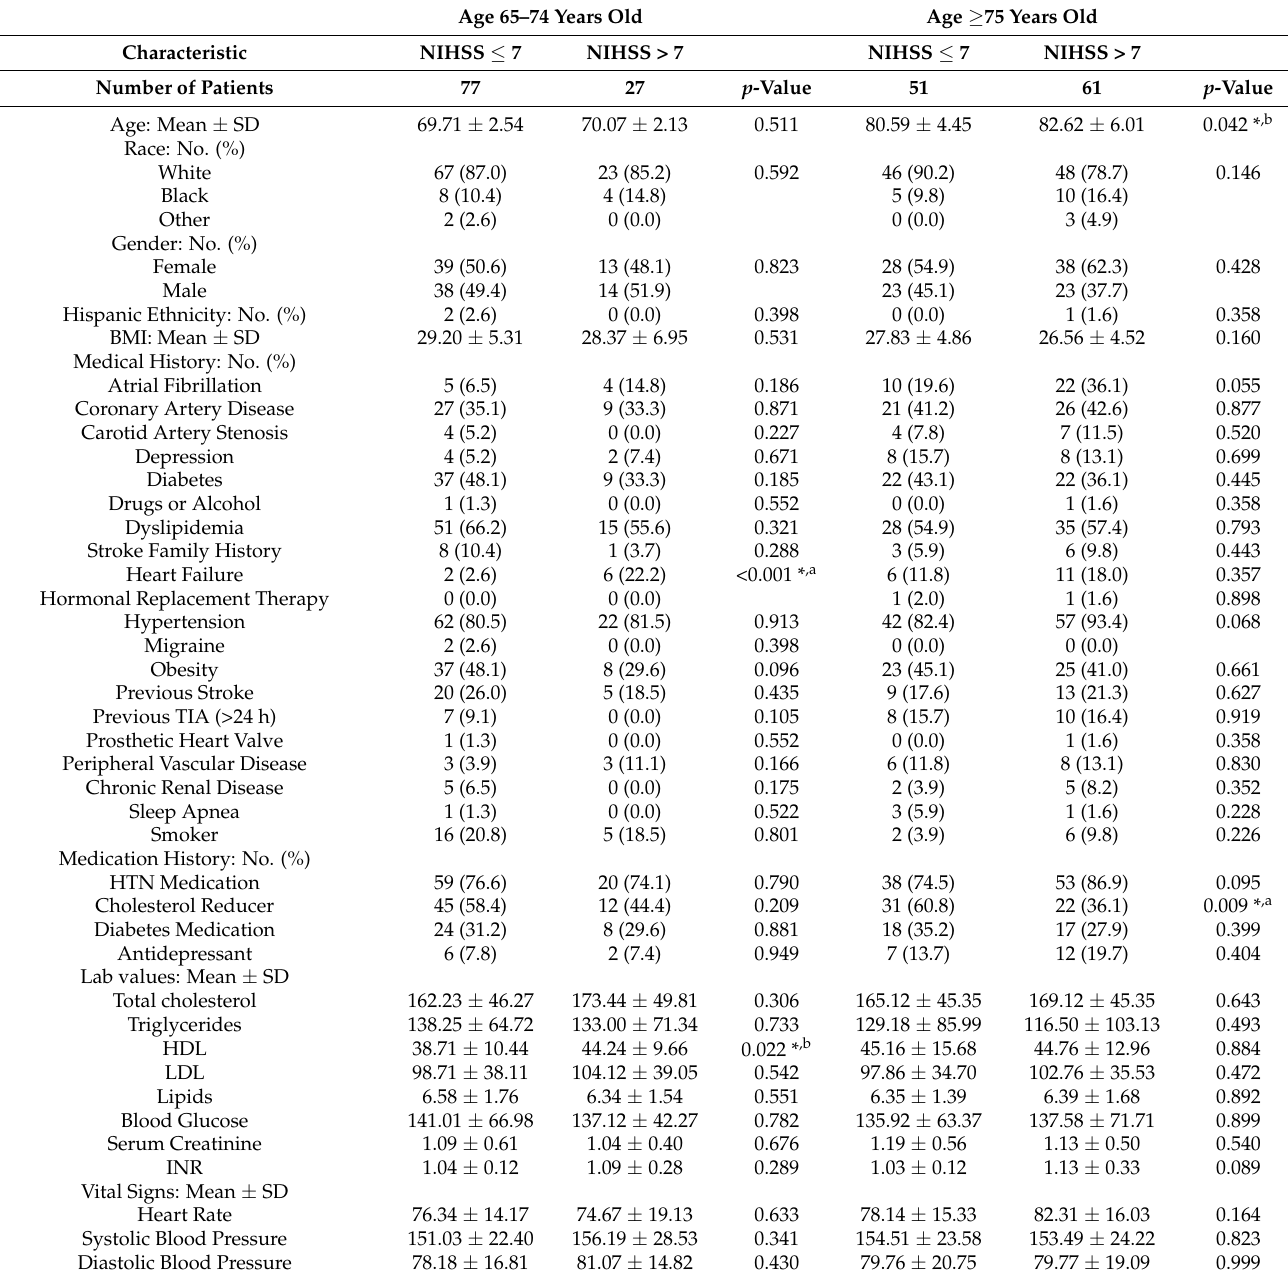
Table 2. Comparison of demographics and clinical characteristics of acute ischemic stroke patients in the telestroke database based on age using NIHSS scores. The demographic and clinical characteristics of ischemic stroke patients in the telestroke database were stratified by age (65–74 years old or ≥ 75 years old). Results for continuous variables are presented as means ± SDs, while discrete data are presented as percentage frequencies. Pearson’s chi-square test was used to compare differences between demographic and clinical characteristics in groups with NIHSS scores greater than 7 in the telestroke database based on age (65–74 years old or ≥ 75 years